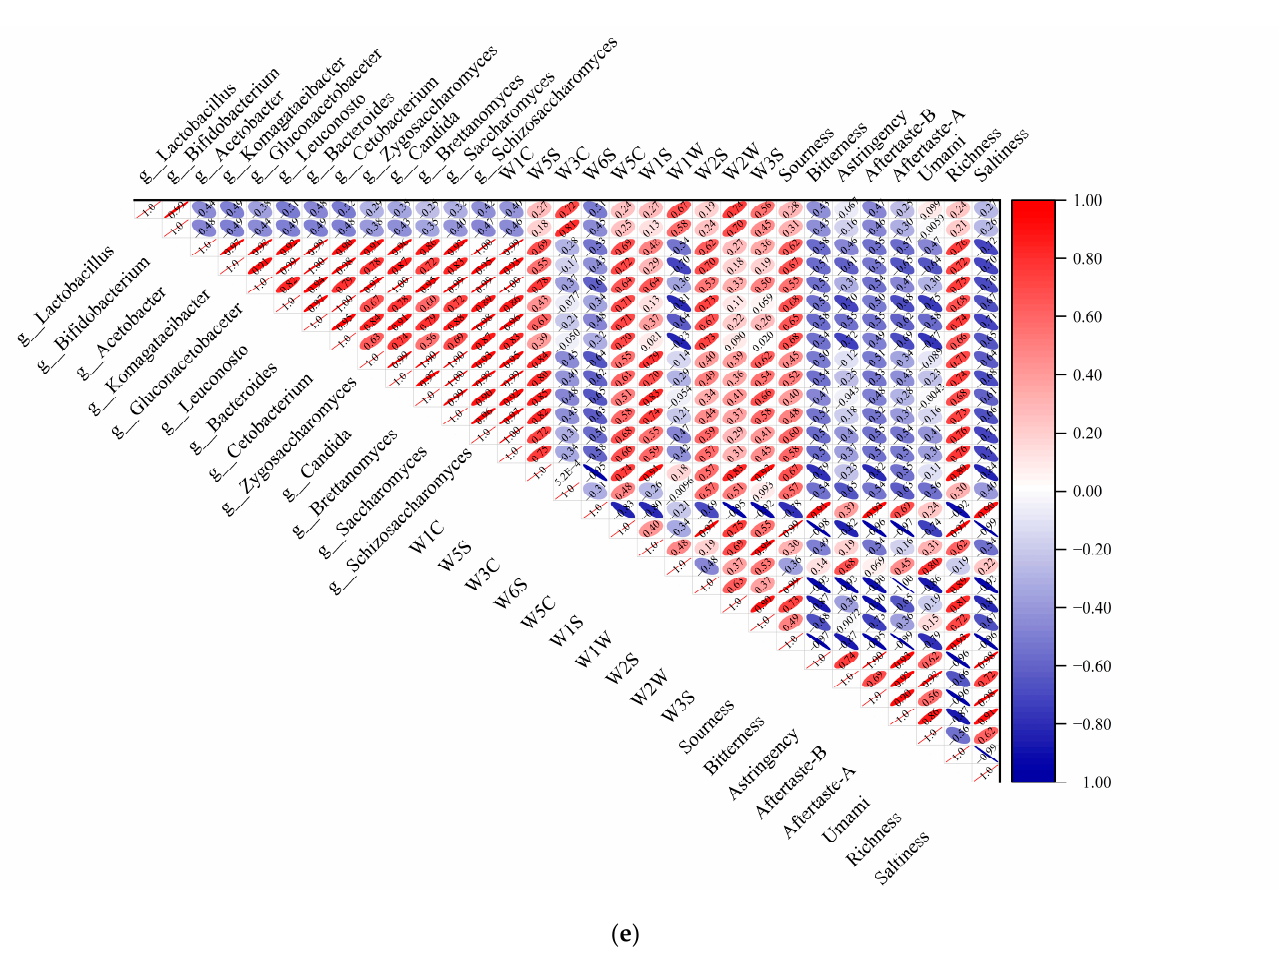
Figure 6. ( a ) Electronic nose radar diagram. ( b ) Principal components for the electronic nose data. ( c ) Electronic tongue radar diagram. ( d ) Principal components for the electronic tongue. ( e ) Correlations among the microbes, smell, and taste.